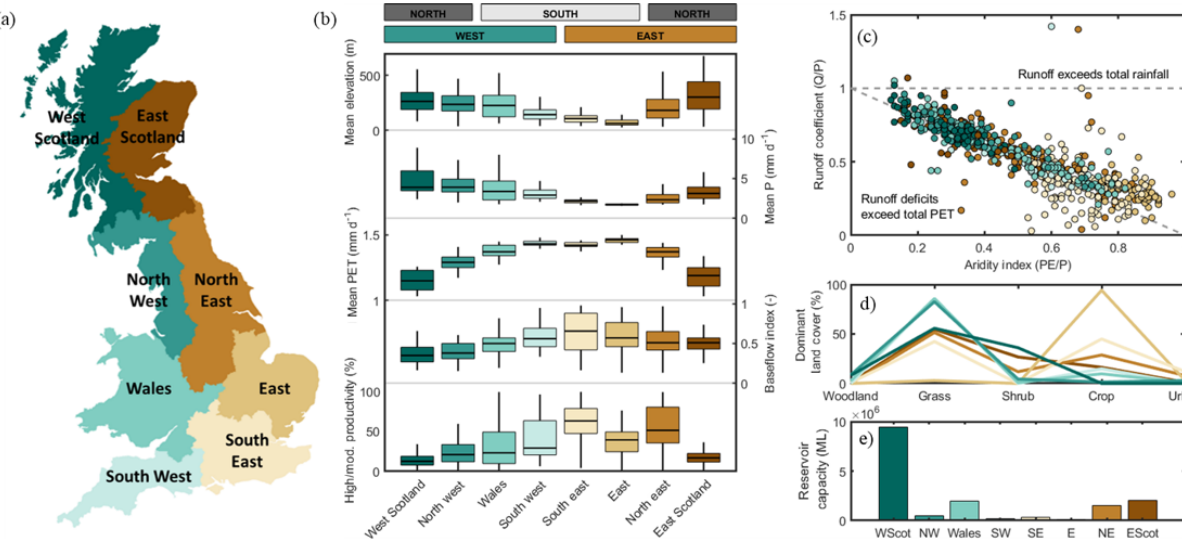
Figure 2. Key catchment variables. (a) Map of Great Britain river basin regions based on the UKCP09 river basins aggregated from 21 river basin districts to eight regions. (b) Box plots showing the range of key climatic, hydrology, and hydrogeologic (defined by the proportion of the catchment underlain by high or moderate productivity aquifers) catchment attributes for each region. (c) Budyko-type curve relating runoff coefficient to aridity index; points are coloured by region, and the y axis is limited to 1.5, which means two gauges (26006 and 27038) are not shown that have a runoff coefficient of 3. (d) The percentage of catchments in each region with a dominant land cover of either woodland (evergreen and deciduous), grass, shrub, crop, or urban. (e) The total reservoir capacity in the catchments in each